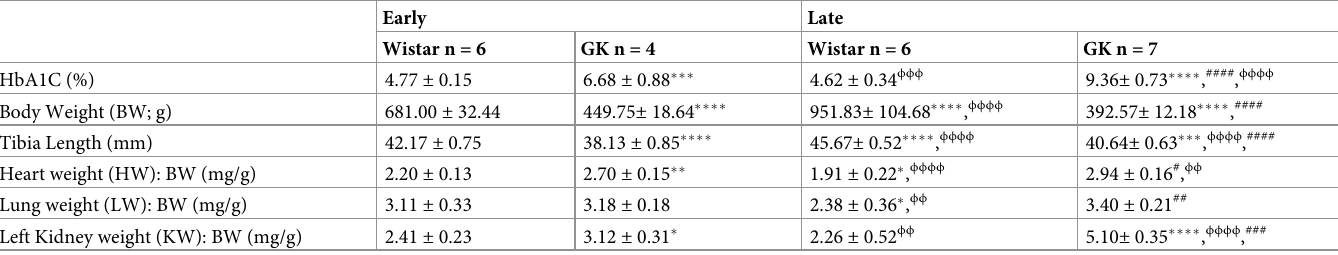
Table 1. Morphometric data of the GK and Wistar rats at early and late